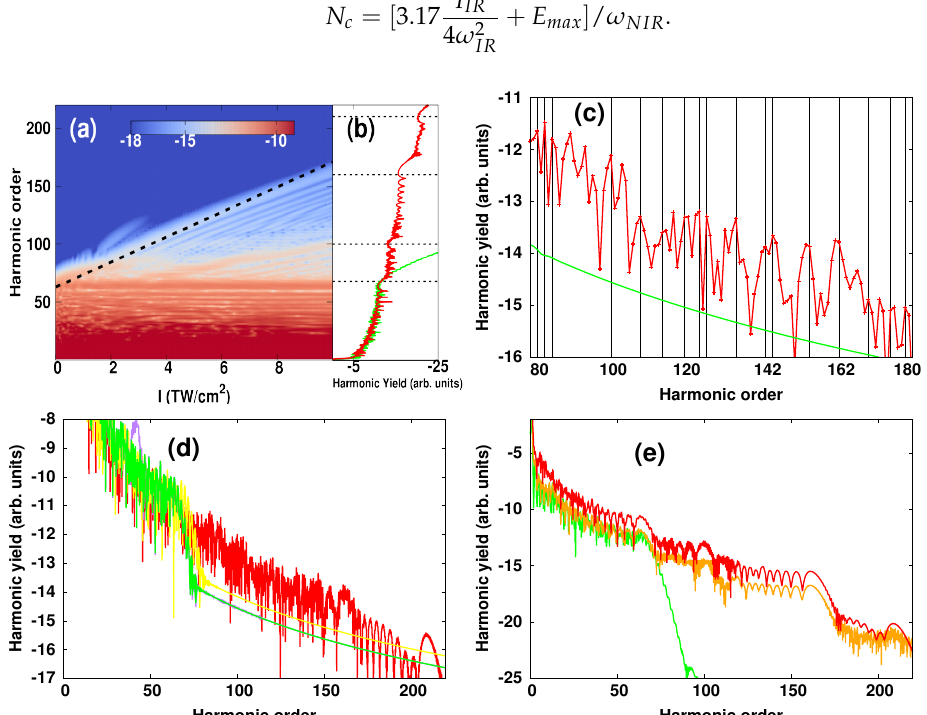
Figure 2. (Color online). ( a – d ) 1D—calculations of HHG. ( a ) Harmonic spectra as functions of the peak intensity of the IR single cycle pulse. ( b ) Harmonic spectra obtained with the assisting IR pulse (red curve) and without (green curve). ( c ) Harmonic spectrum as in ( b ) but in the harmonic order range [80:180], in which even—order harmonics are indicated by vertical lines. ( d ) Harmonic spectra obtained with different assisting fields having the same peak intensity and without using a Gaussian window: (purple curve) XUV—assisting field ( ω XUV = 41 eV and τ XUV = 1 fs), (yellow curve) NIR— assisting field ( ω NIR = 0.976 eV and τ NIR = 42.4 fs ) and (red curve) IR single cycle assisting field ( ω IR = 0.0976 eV, τ IR = 42.4 fs). For reference, the spectrum obtained in the absence of the assisting field is also plotted (green curve). ( e ) 3D—calculations of the harmonic spectra as in ( b ): with the assisting IR pulse (orange curve) and without (green curve). For comparison, the spectrum obtained using the 1D—model is also shown (red curve). Yields are shown in log scale. The parameters of the NIR pulse are: λ NIR = 1.27 µ m, T c = 10 cycles, δφ = 0 and I NIR = 1 × 10 14 W/cm 2 . The parameters of the IR pulse are: λ IR = 12.7 µ m and I IR = 1 × 10 13 W/cm 2